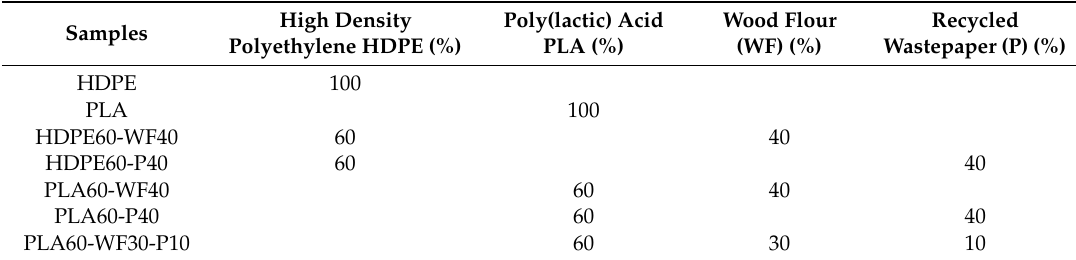
Table 1. Formulations of samples for composting test in